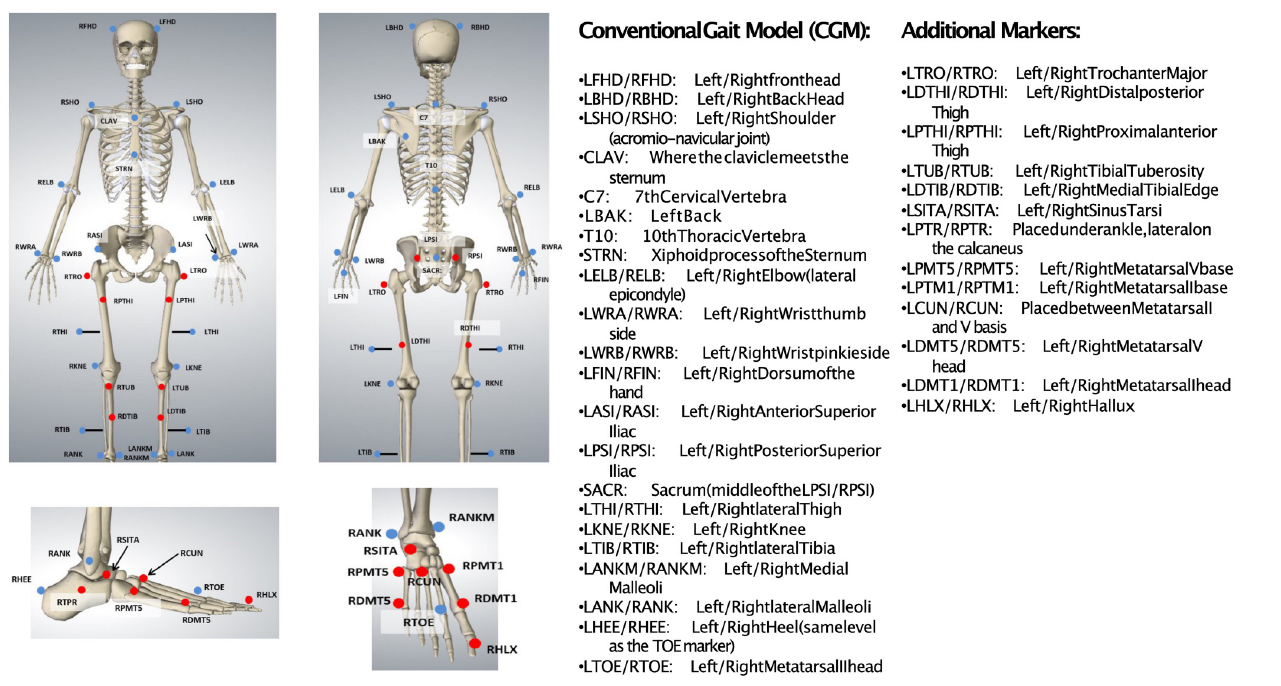
Fig 1. An overview of modified Conventional Gait